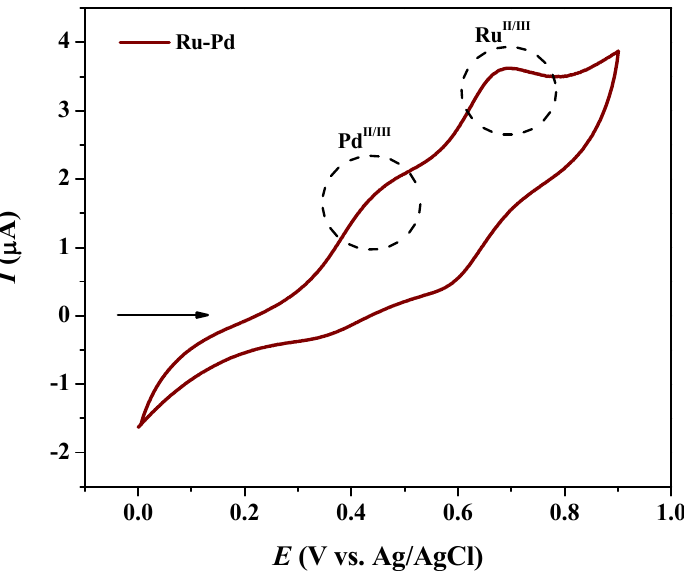
Figure 3. Cyclic voltammogram of Ru–Pd obtained in n -Bu 4 NPF 6 /CH 2 Cl 2 0.1 mol L  1 vs. Ag/AgCl at a scan rate of 100 mV s  1 ; [Ru/Pd] = 1.0  10  3 mol L  1